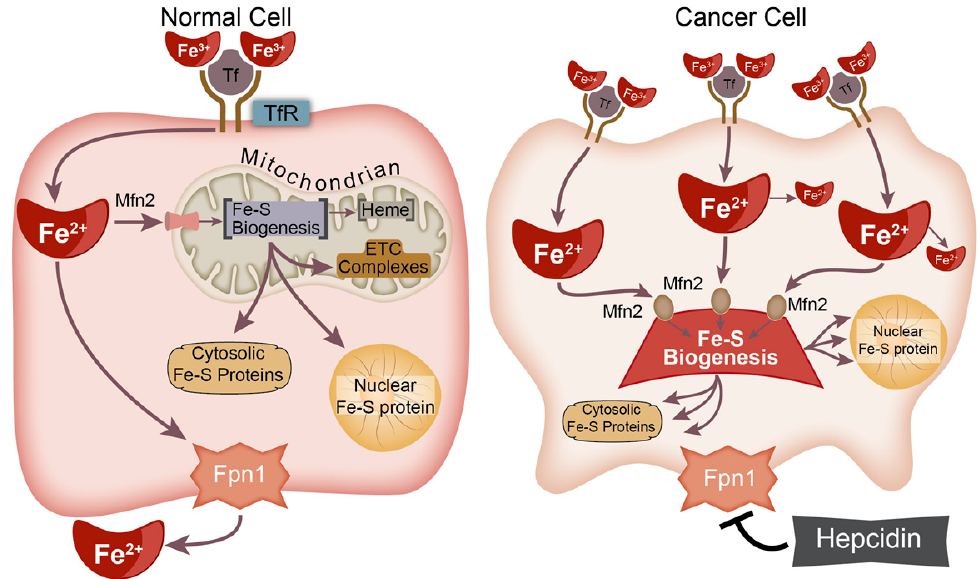
Figure 1. Fe–S biogenesis is theorized to represent a fundamental difference between cancer and non-malignant cells. Cancer cells frequently exhibit a phenotype characterized by preferential Fe uptake and downregulation of Fe export. The underlying mechanism is unclear, but we hypothesize that this may be related to increased cancer cell needs for Fe–S biogenesis to produce cytosolic and nuclear Fe–S proteins necessary for cancer cell survival.